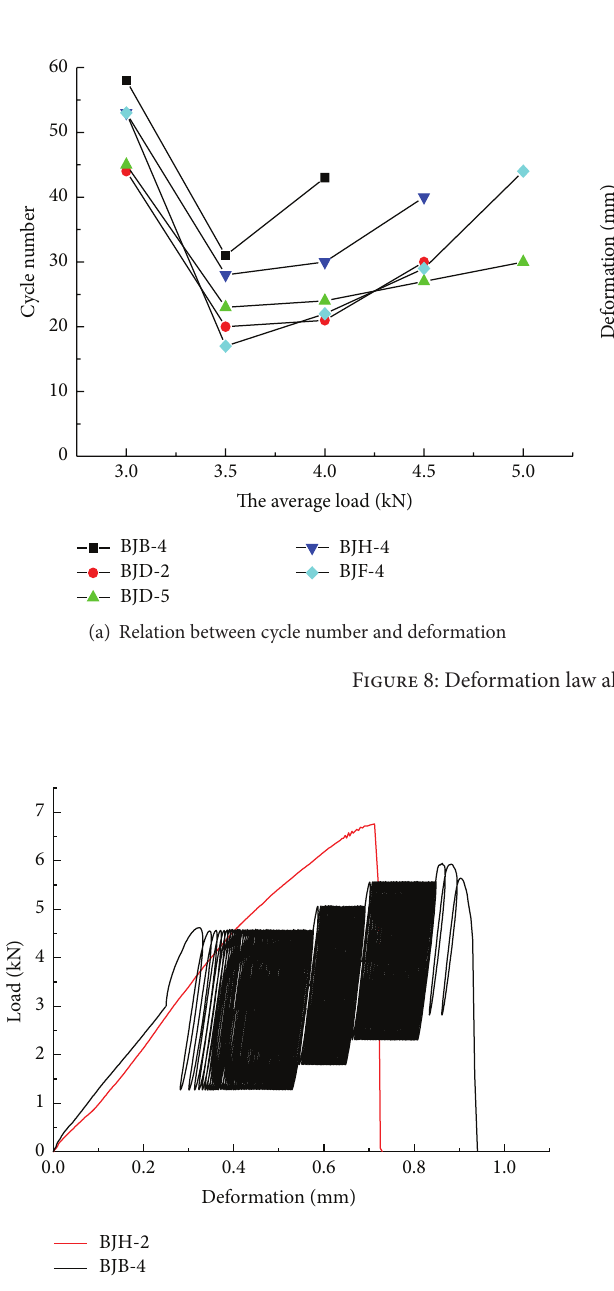
more intergranular fracture characteristics, observing the other fracture morphology of the specimen, accompanied by a small amount of coupling of transgranular fracture. On the fracture scanning area of specimen BJH-1, the fracture surface of the specimen forms irregular steps and the contact area of the fracture surface is very small, showing distinct transgranular fracture characteristics, observing the other fracture morphology of the specimen, following that